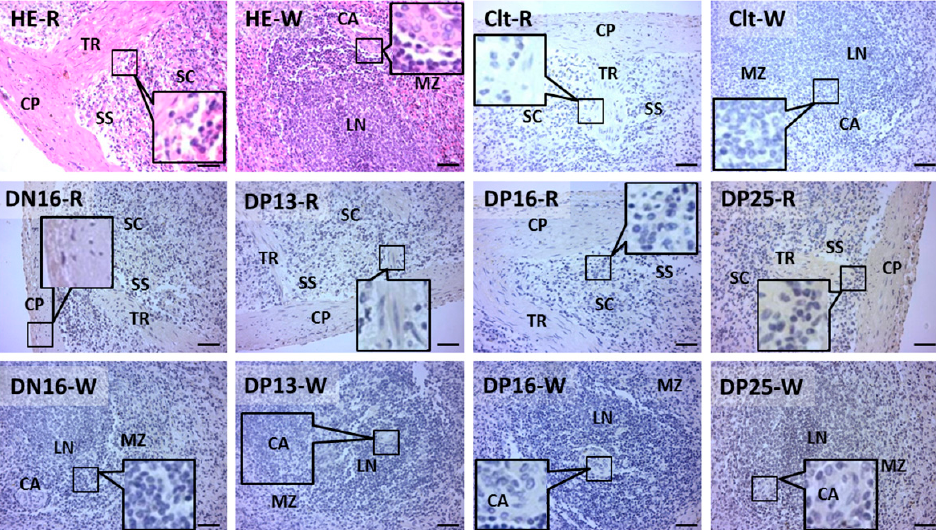
Figure 3. Immunohistochemical localization of C3 protein in the spleen. The spleen is divided into red pulp (R) and white pulp (W) and surrounds the thickened capsule (C). The capsule (CP) with several trabeculae (TR) projects into the substance of the spleen. Note: HE = stained by hematoxylin and eosin; Clt = negative control; SS = splenic sinuses; SC = splenic cords; MZ = marginal zone; LN = lymphoid nodule; CA = central arteriole; DN16 = day 16 of the estrous cycle; DP13 = day 13 of gestation; DP16 = day 16 of gestation; DP25 = day 25 of gestation. Bar = 50 μ m.